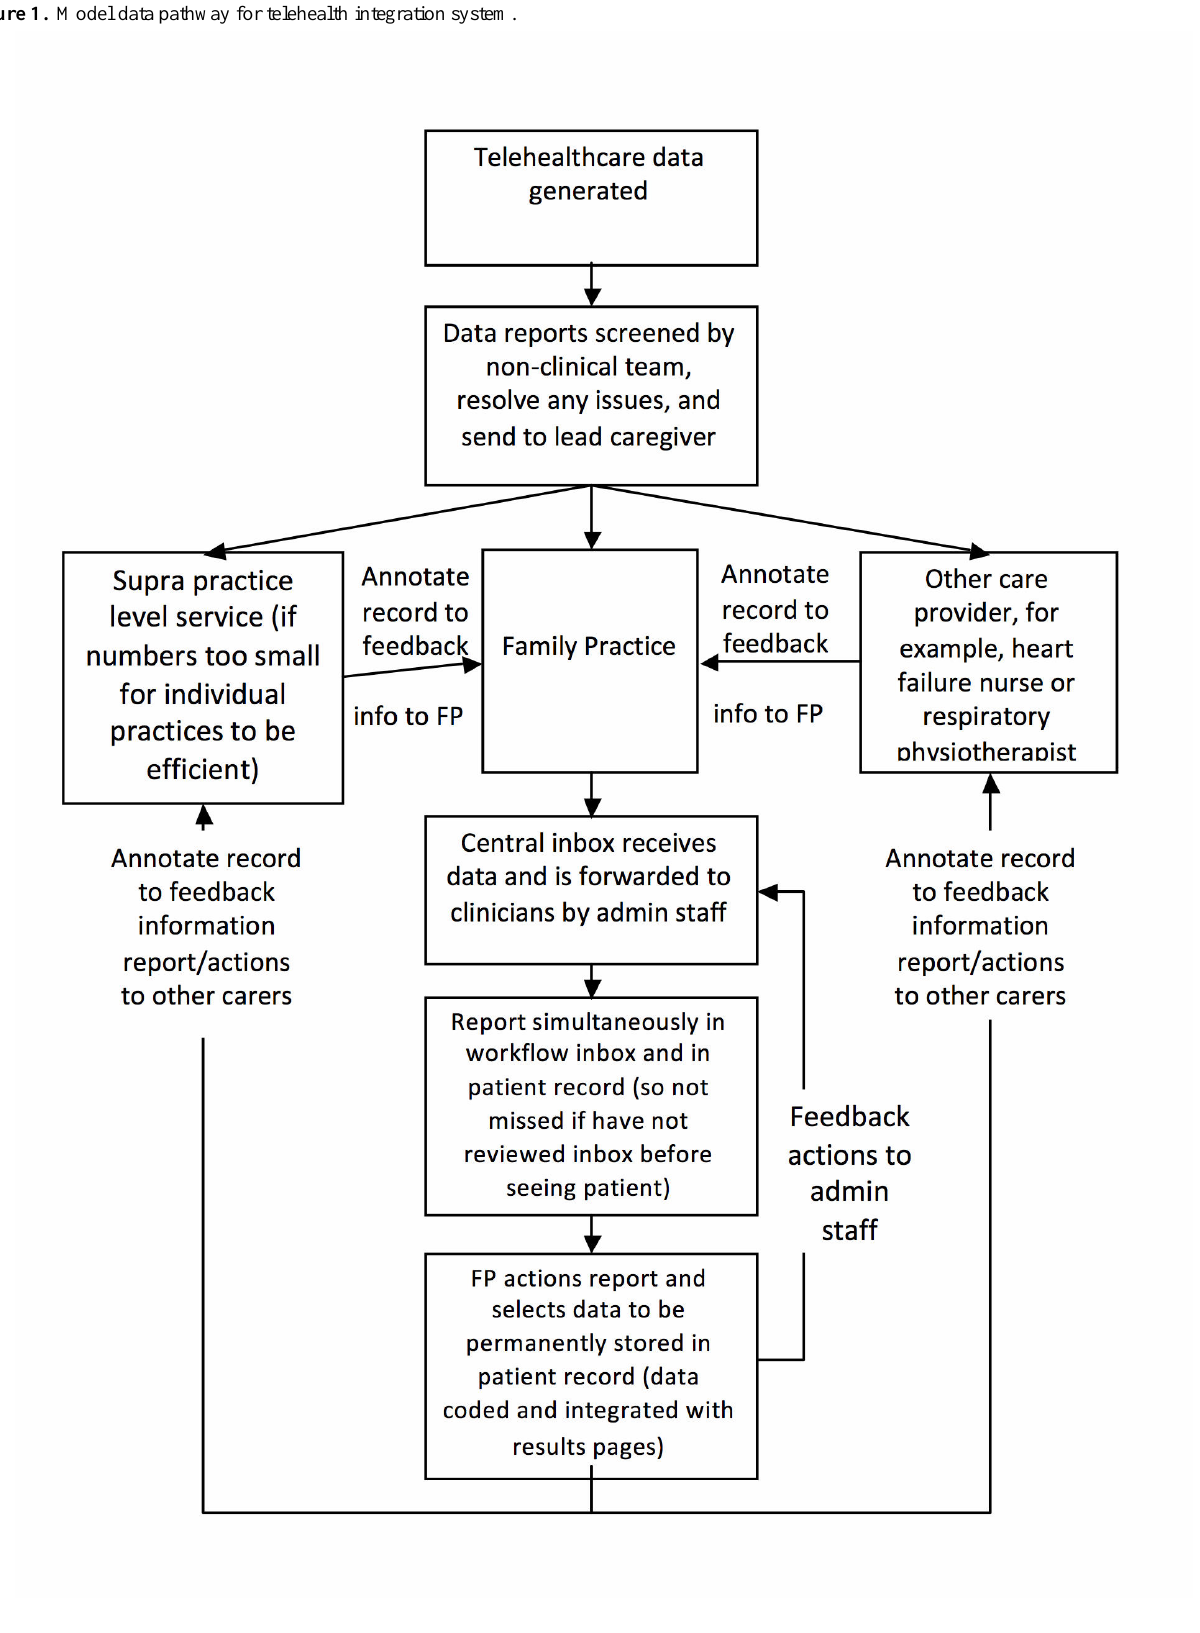
Figure 1. Model data pathway for telehealth integration